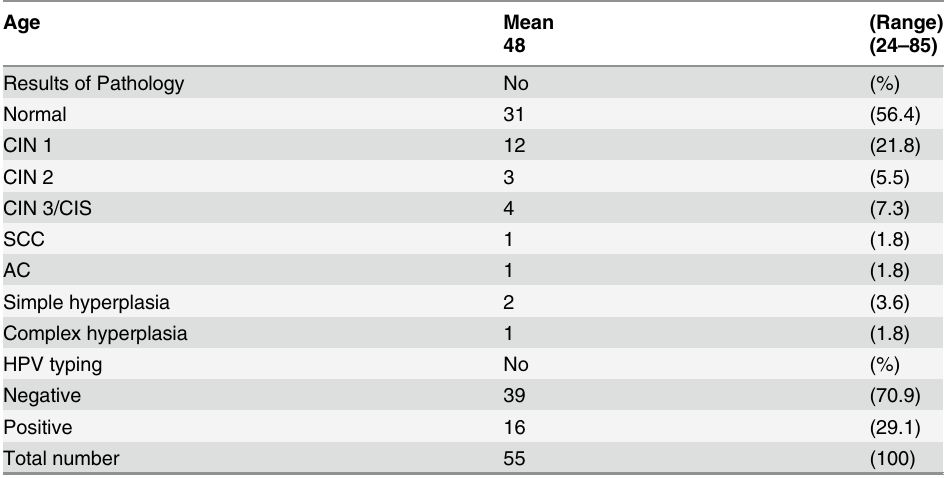
Table 1. Pathology and HPV results of AGC